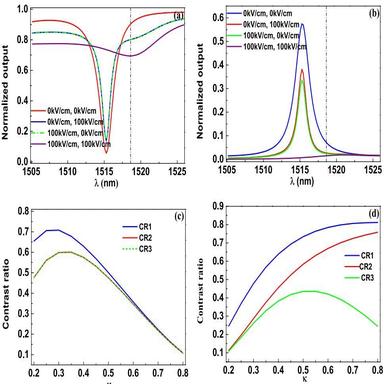
Wavelength and coupling coefficient dependency of a parallel EA MRR based AND/NAND gate. (a) Normalized T port power as a function of wavelength at various operands (field applied on rings) and κ = 0.35. (Dotted line shows λ = 1518.61 nm which is resonant at F = 100 kV/cm), (b) Normalized D port power as a function of wavelength at various operands and κ = 0.35, (c) CR at T port as a function of coupling coefficient with applied field as 100 kV/cm, λR = 1515.27 nm, (d) CR at D port as a function of coupling